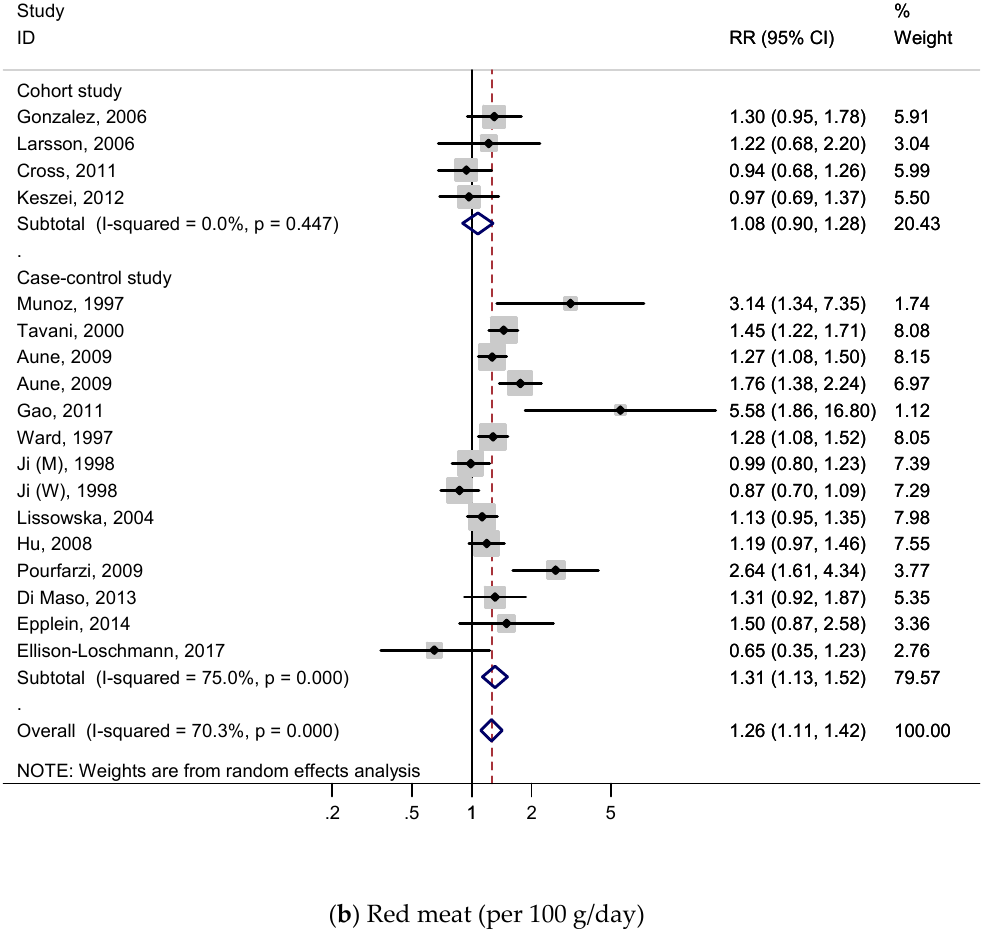
Figure 2. Adjusted relative risks and 95% confidence intervals of gastric cancer for red meat consumption. Squares indicate each study’s relative risks. Horizontal lines indicate 95% confidence intervals. Diamonds indicate the summary relative risks and 95% confidence intervals. ( a ) Highest versus lowest categories of red meat consumption; ( b ) dose–response meta-analysis for 100 g/day increase in red meat consumption.